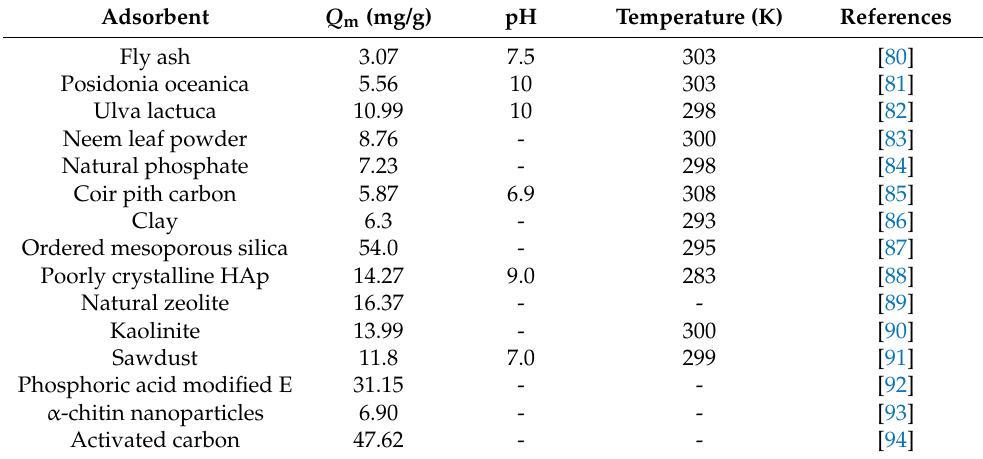
Table 5. Comparison of adsorption capacities of various adsorbents for MB removal.